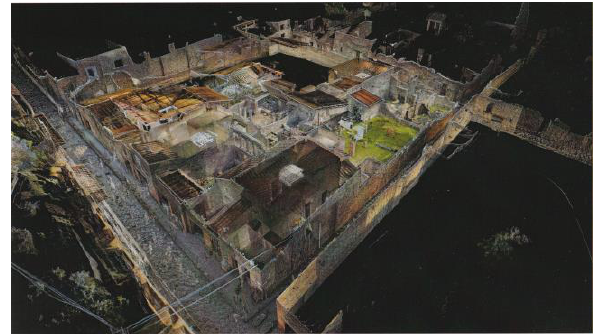
Figure 6. Regio I, insula 6, 3D survey conducted using laser scanner technology and photogrammetry (Osanna, 2018).